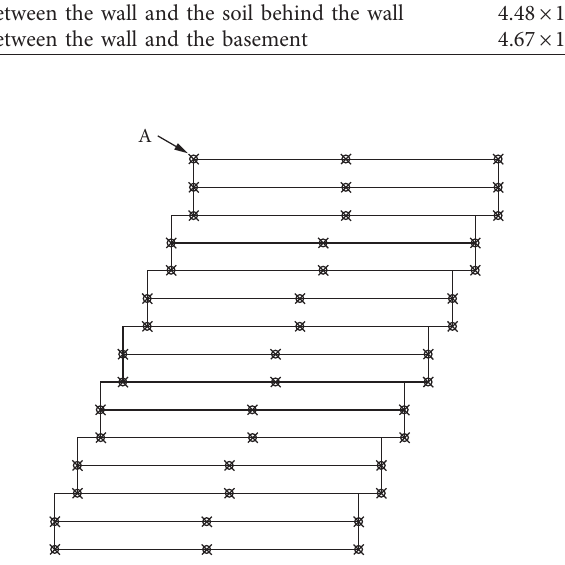
Figure 4: Layout of the monitoring point.